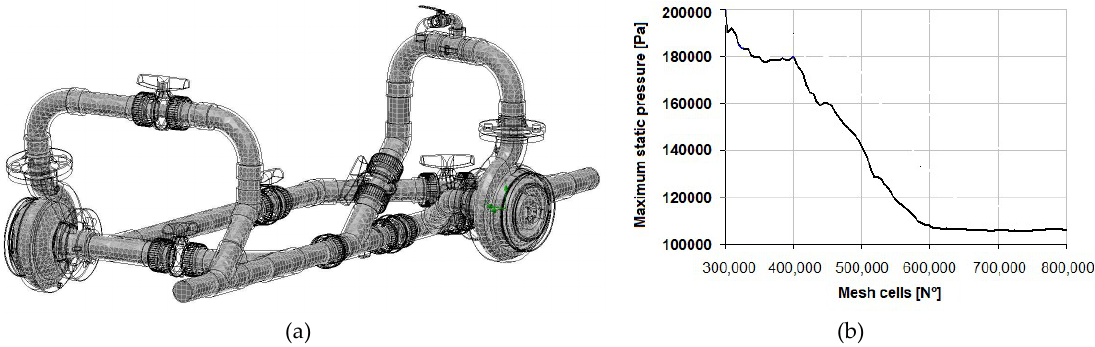
Figure 9. Computational fluid dynamics (CFD) model: ( a ) defined mesh; ( b ) convergence of maximum static pressure results vs. different number of mesh cells.